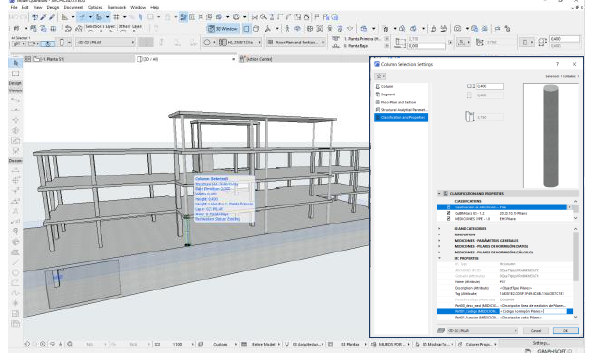
Figure 1. a. Structural model of the building; b. Definitions of the selected parametric object (IFC parameters).